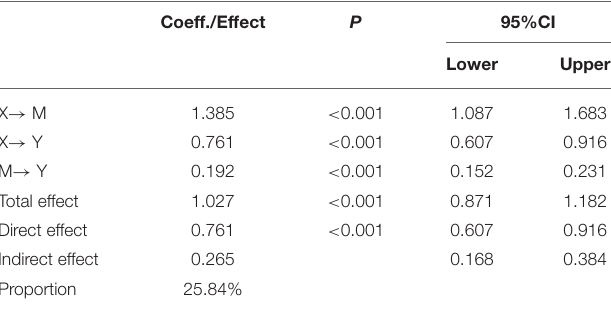
TABLE 3 | Total, direct, and indirect effect of social support on coping style via psychological resilience.